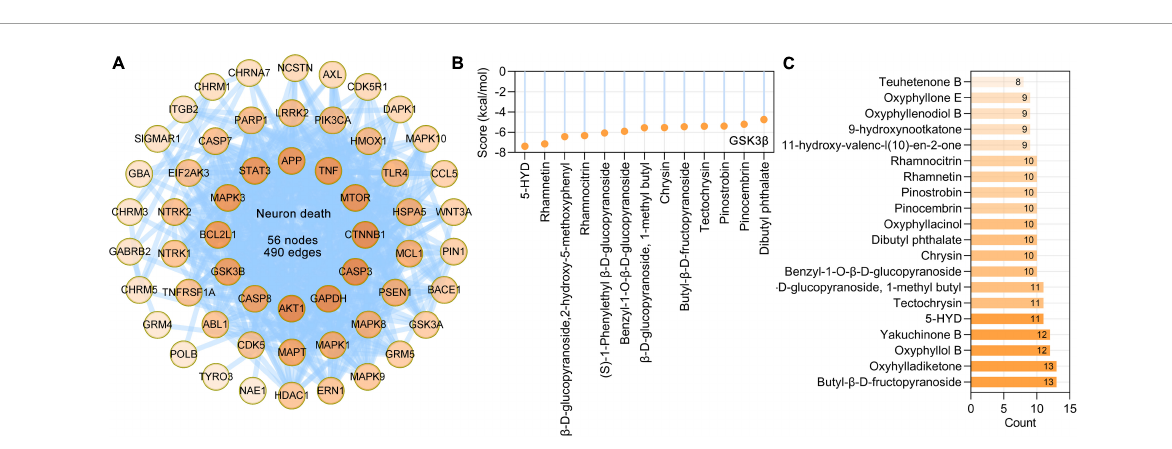
FIGURE8 Alpinia oxyphylla Miquel (AO) targets and their phytochemicals targeting neuron death. (A) The PPI network of AO targets related to neuron death was constructed by STRING database. (B) Number of AO phytochemical targets targeting neuron death. (C) Molecular docking of